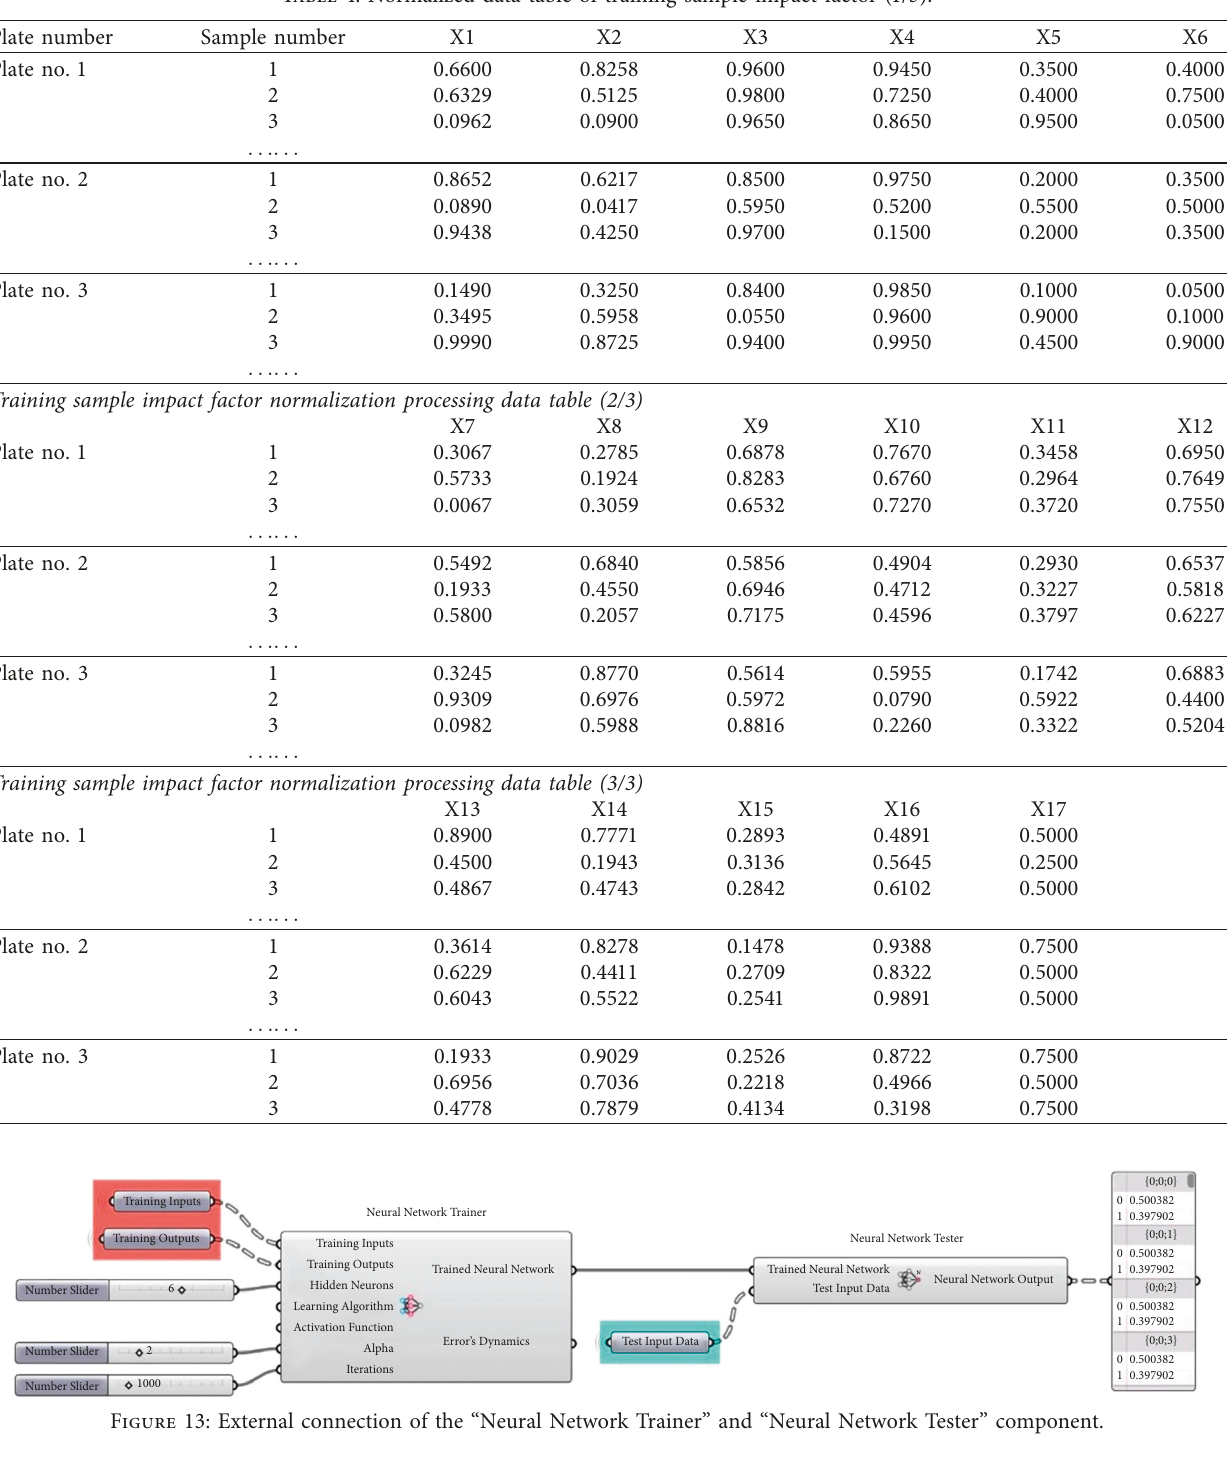
Table 4: Normalized data table of training sample impact factor (1/3).